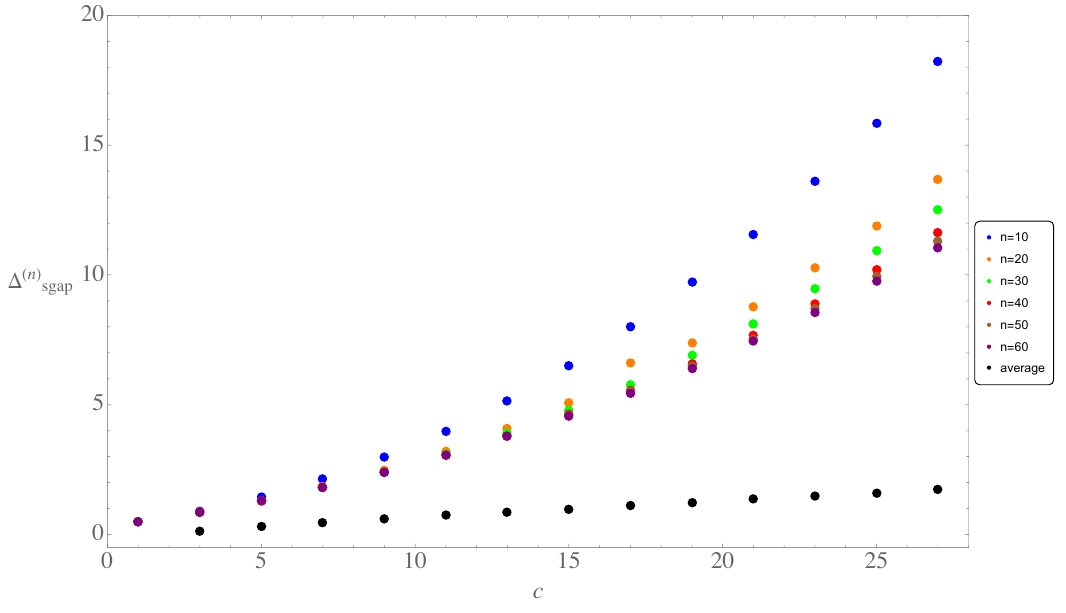
Figure 3 . Plot of a bound on the scalar gap for U(1) c CFTs at odd c ≤ 27 . The colors blue, orange, green, red, brown, and purple represent the bound we get at 10 , 20 , · · · , 60 derivatives respectively. The color black represents the average Narain scalar gap, for comparison. (However, there is no a priori reason the average Narain scalar gap and the optimal U(1) c scalar gap should be similar.) See table 1 for the numerical